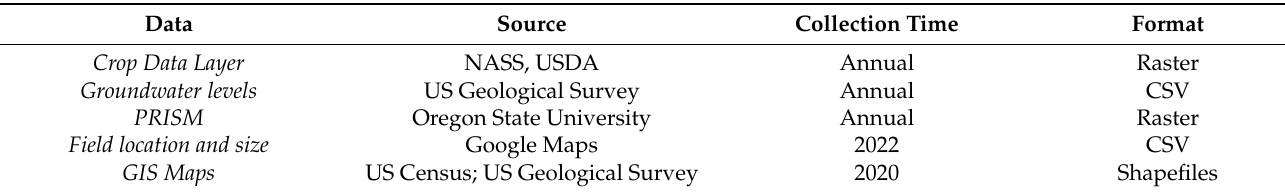
Table A1. Supplemental information on datasets used in this